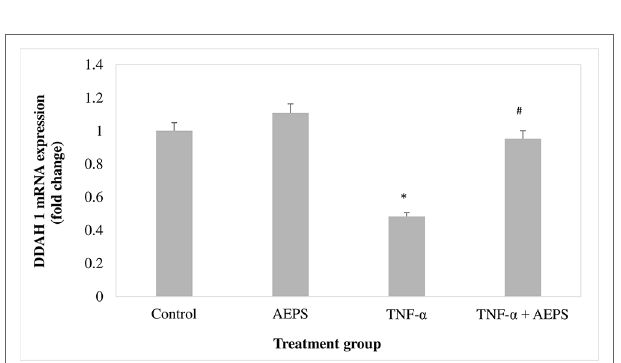
FIGURE 3 | DDAH1 messenger RNA (mRNA) expression in human umbilical vein endothelial cells (HUVEC). Data shown as mean ± SEM, n = 6 [* P < 0.05 compared with the control group, # P < 0.05 compared with tumor necrosis factor (TNF)- α